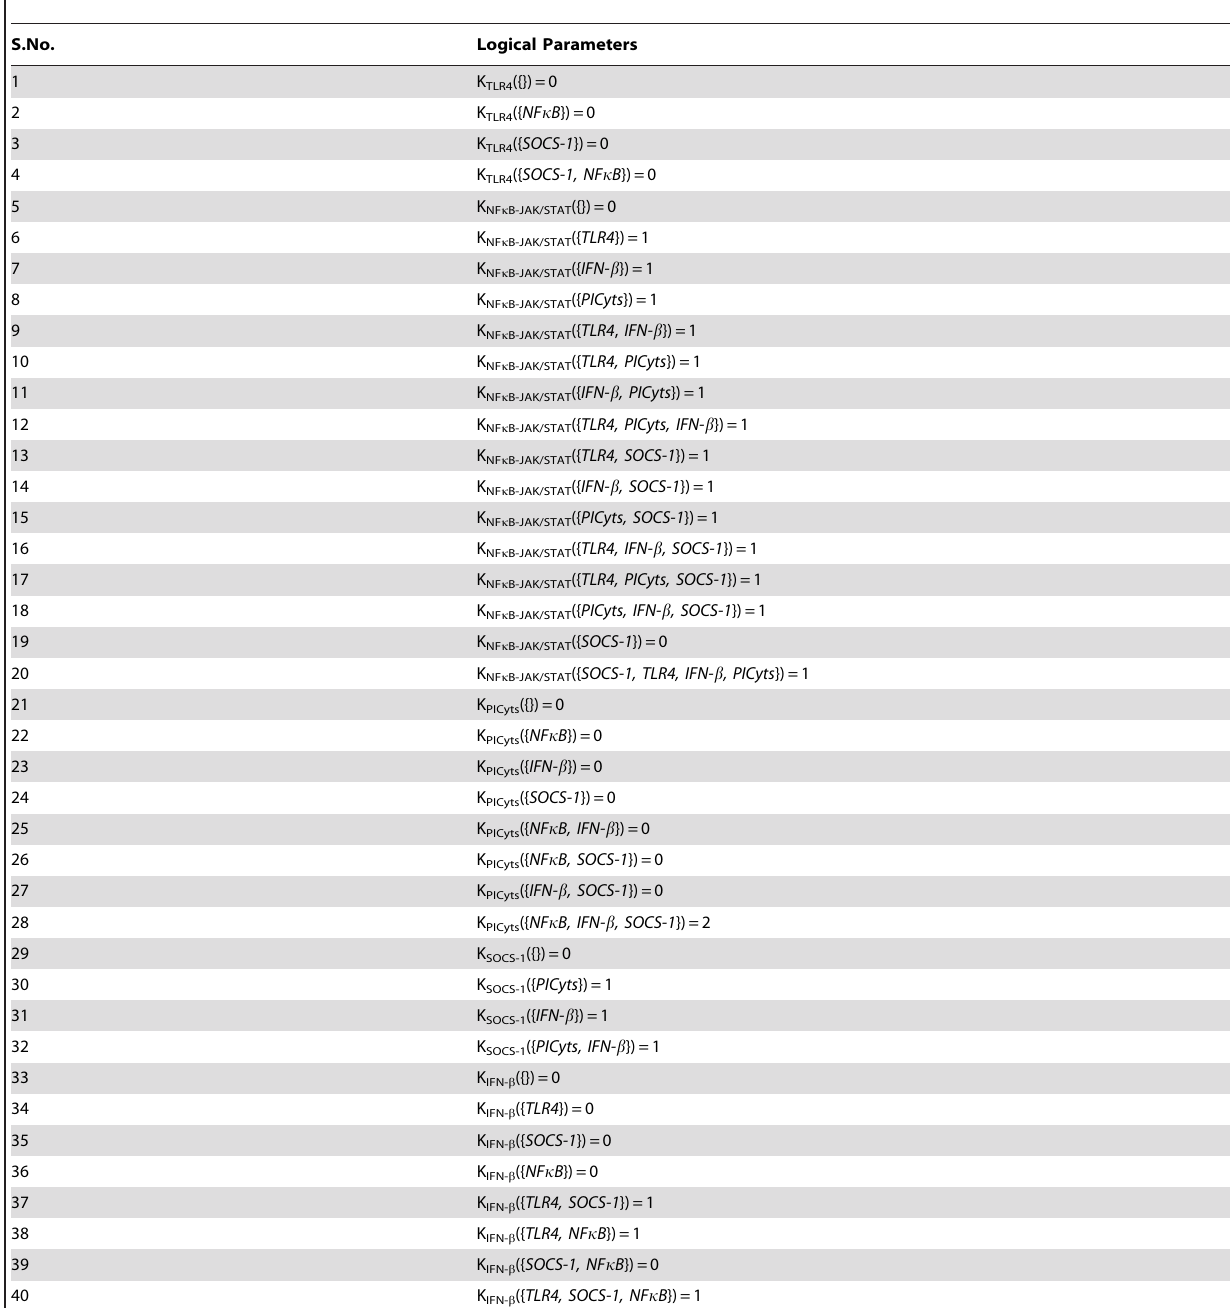
Table 1. Logical parameters used for each entity in modelling of non-septic TLR4 and JAK/STAT signalling using the BRN shown in Figure 2.